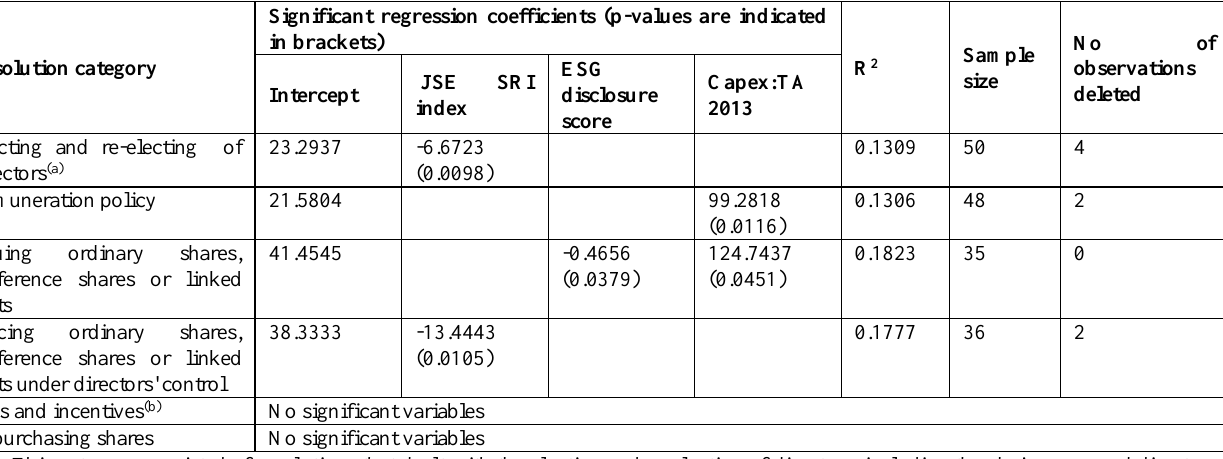
Table 6: Statistically significant relationships Significant regression coefficients (p-values are Resolution category